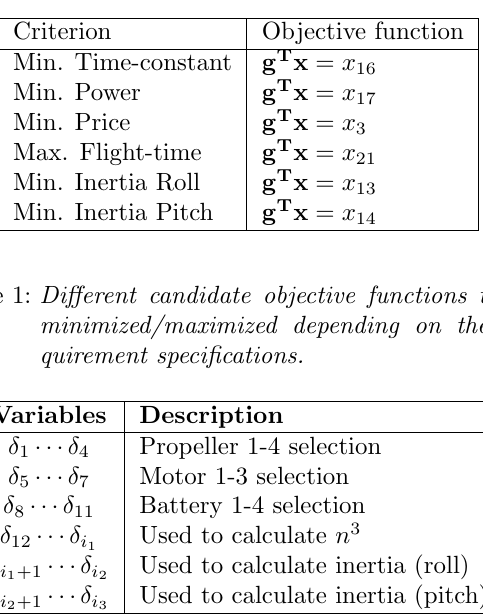
Table 2: Boolean decision variables. If δ = 1 , then the corresponding component/region is selected. If δ = 0 , the component/region is not